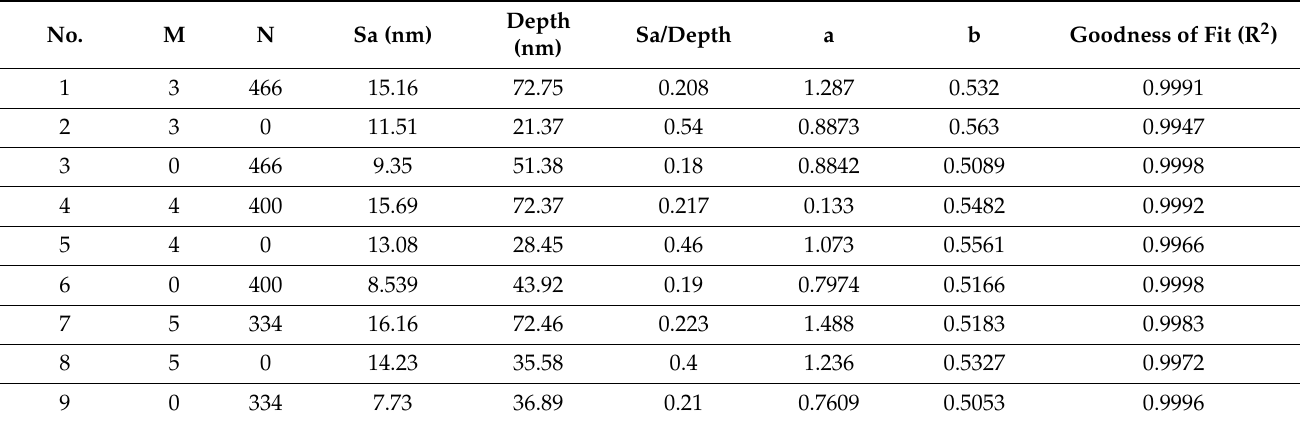
Table 4. Changes in the surface roughness caused by the proportion of pits in different removal